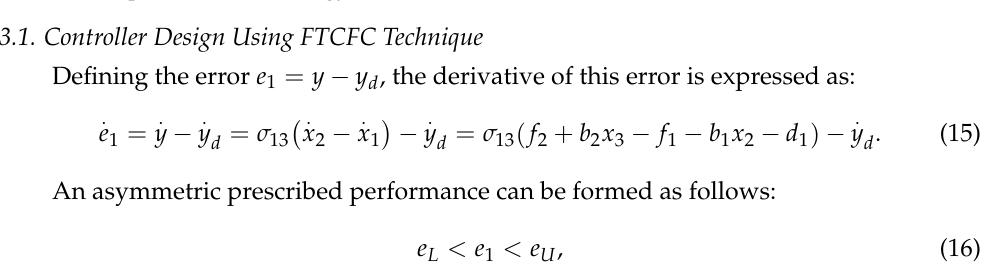
Figure 2. Proposed control strategy scheme.